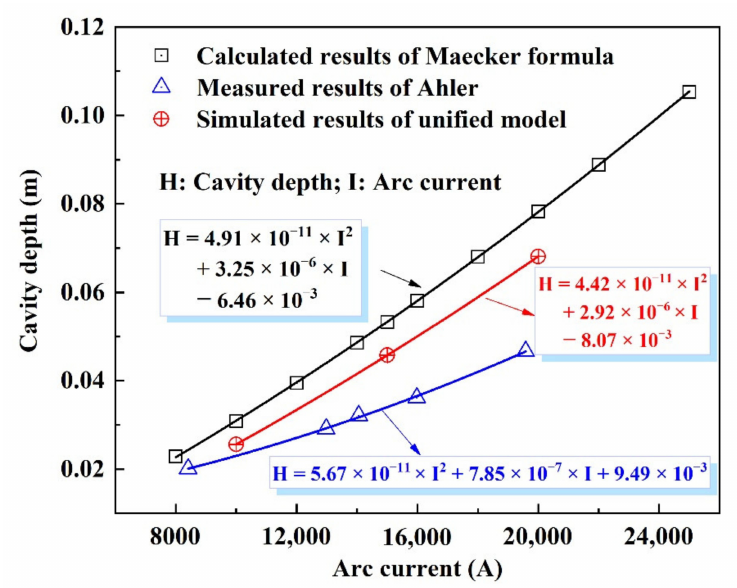
Figure 3. Comparison of cavity depth between the calculated results of Maecker’s formula, measured results of Ahler, and simulated results of the unified